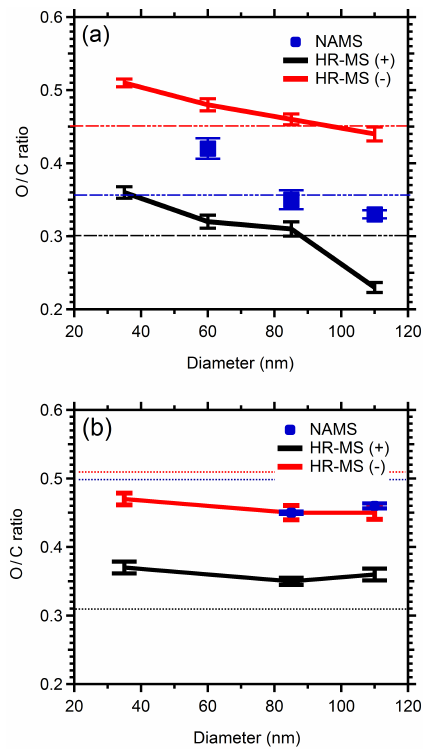
Figure 2. Average O / C ratio vs. particle diameter for SOA (a) gen- erated from the flow tube reactor and (b) re-aerosolized from the atomizer. Dashed lines in the plots give the O / C ratios of the cor- responding polydisperse SOA samples. Blue markers represent data obtained by NAMS. Black (positive-ion mode) and red (negative- ion mode) markers represent data obtained by HR-MS. Error bars represent 1 standard deviation for the five replicate